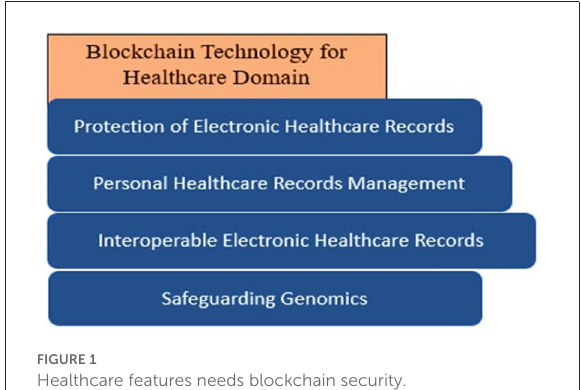
FIGURE1 Healthcare features needs blockchain security.